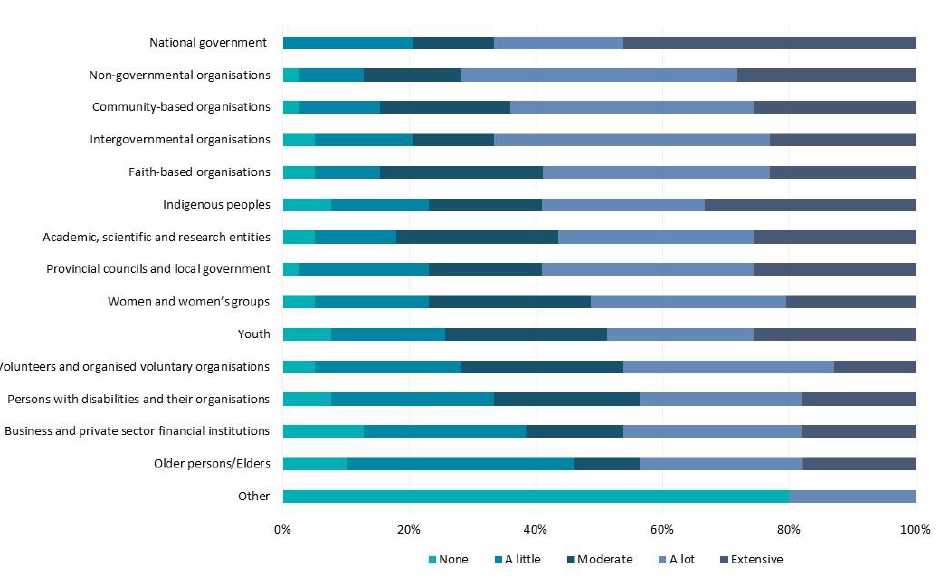
Figure 1. Importance of various stakeholders in currently responding to NELD in the Pacific